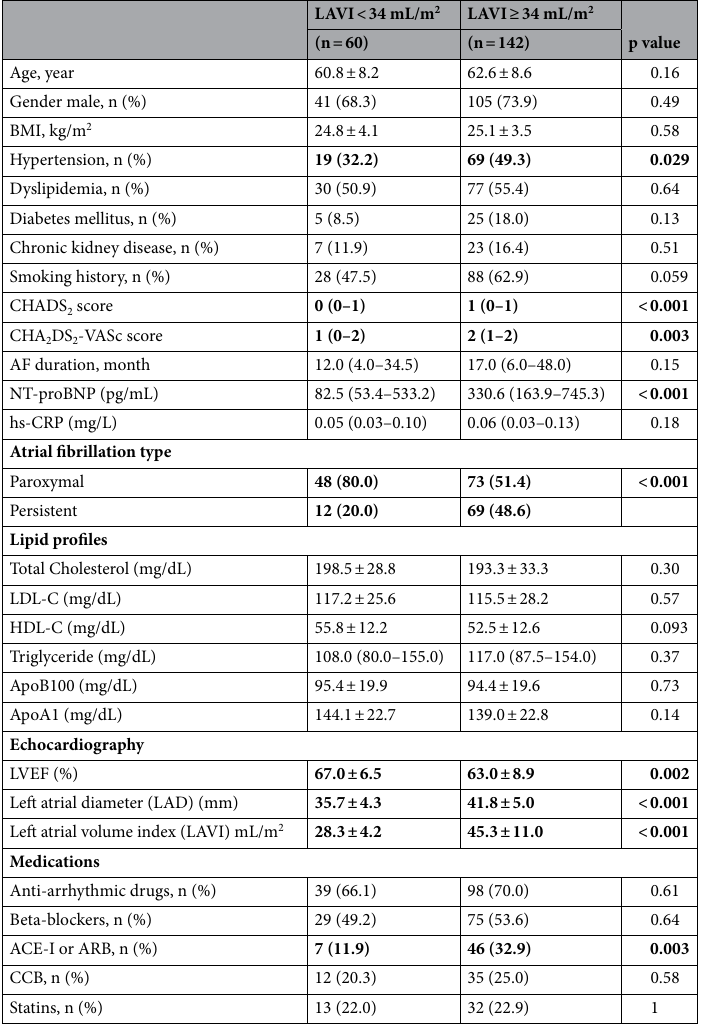
Table 1. Background demographics of patients with or without advanced LA remodeling. ACE-I indicates angiotensin-converting enzyme inhibitor; ARB, angiotensin receptor blocker; ApoA1, apolipoprotein